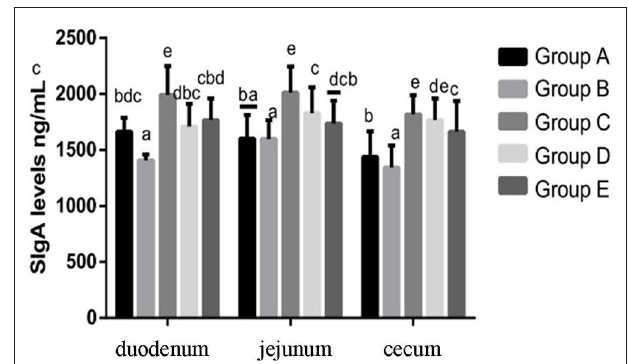
FIGURE 7 | TNF- α protein expression in duodenum, jejunum and cecum of different treatment groups. Group A, control group; Group B, infection group; Group C, JYBR-190 pre-fed group; Group D, JYBR-190 fed group; Group E, antibiotic group. Data are expressed as mean ± standard deviation (SD). Different lowercase letters on the columns indicate significant differences ( P < 0.05); the same lowercase letters indicate no significant difference ( P > 0.05).